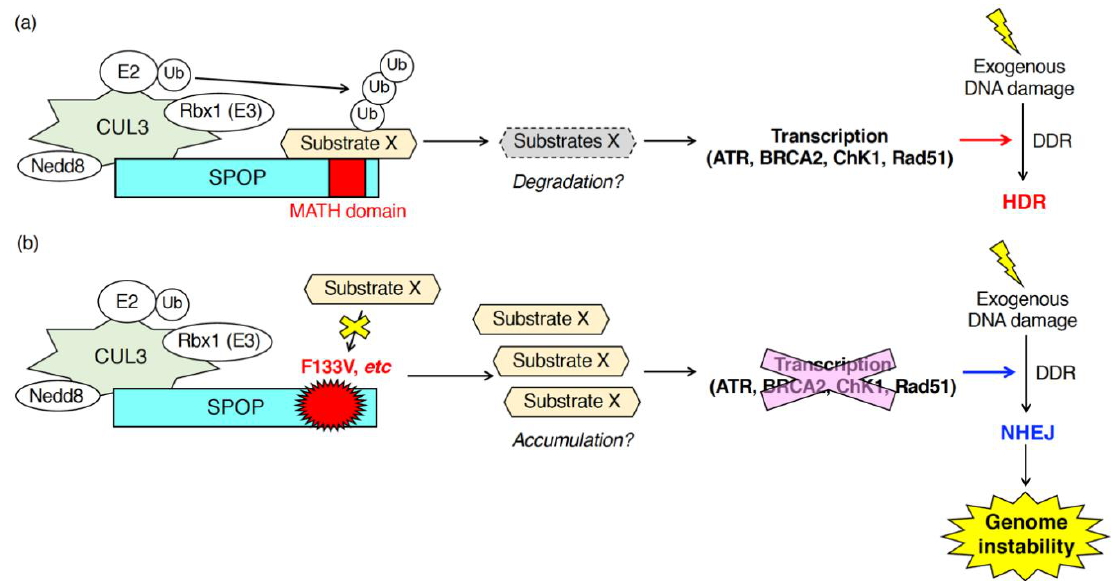
Figure 2. Patho-physiological roles of SPOP during the DNA damage response (DDR) in response to exogenous DNA damages. SPOP is essential for the mRNA expression of various DNA repair-related genes(ATR,BRCA2, ChK1, Rad51). ( a )Incellsexpressingwild-typeSPOP,ubiquitinationofunidentified substrates promotes transcription of ATR, BRCA2, ChK1 and Rad51 leading to the proper DDR followed by error-free homology-directed repair (HDR) in response to exogenous DNA damages. ( b ) In cells expressing the F133V mutant of SPOP, inhibition of ubiquitination of substrates suppressed transcription of ATR, BRCA2, ChK1 and Rad51. Low expression of those genes promotes NHEJ after exposure to exogenous DNA damage leading to the generation of genome